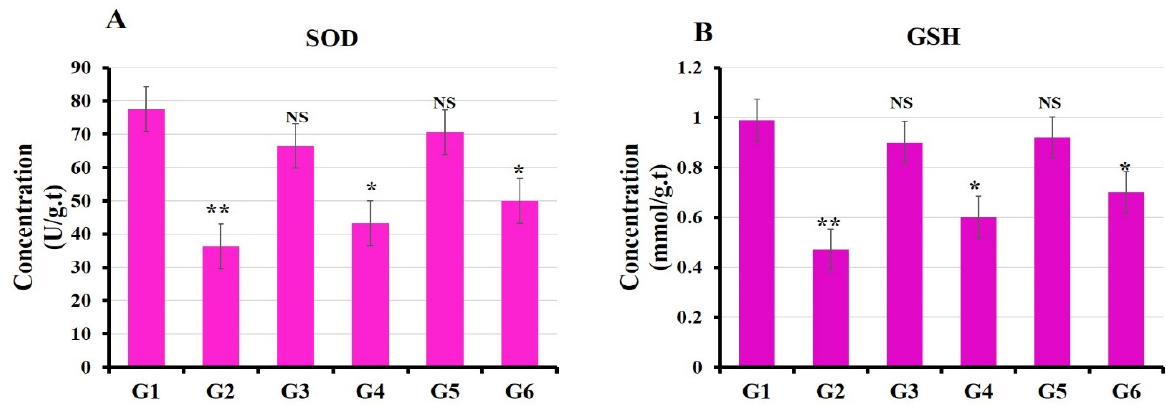
Figure 6. Effect of both Moringa and nano-Moringa leaf extracts on antioxidant enzyme activities in the liver tissue homogenates of Bisphenol A—Exposed versus normal rats. G1: control. G2: BPA. G3: MOLE. G4: MOLE-BPA. G5: Encap. MOLE. G6: Encap. MOLE-BPA. The data are shown as * p < 0.05 and ** p < 0.01.